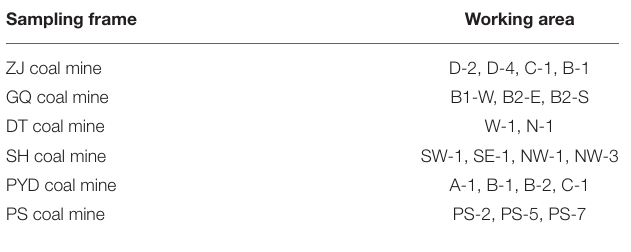
TABLE 3 | Sampling frame distribution table.